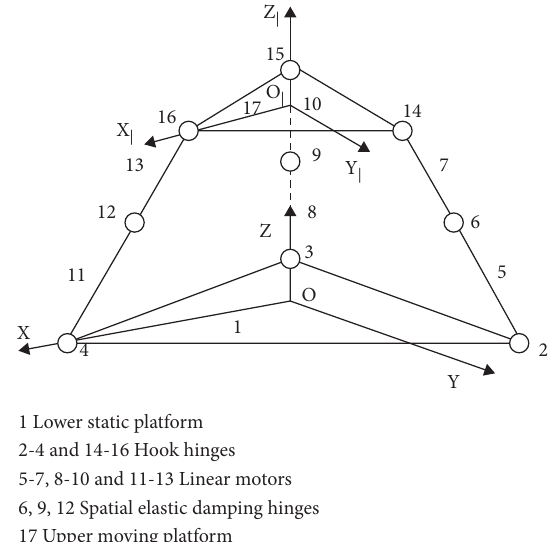
Figure 3: Schematic diagram of the 3-UPU parallel mechanism.